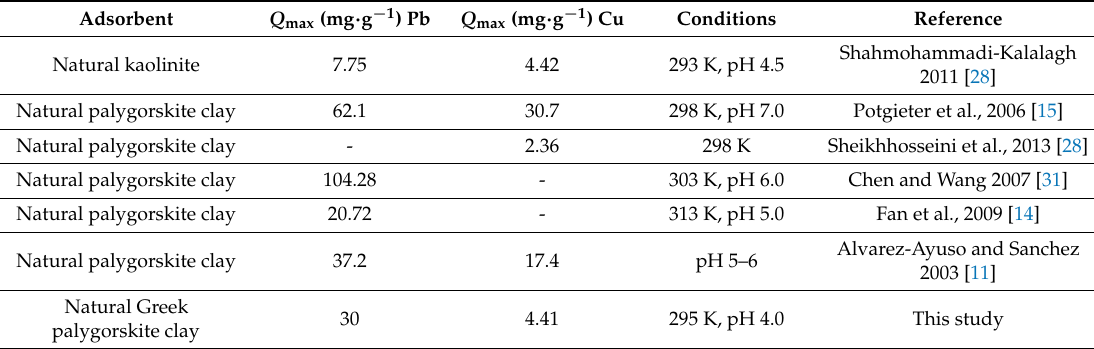
Table 3. Comparison of maximum adsorption capacities for Pb and Cu (Langmuir model) by different raw clay